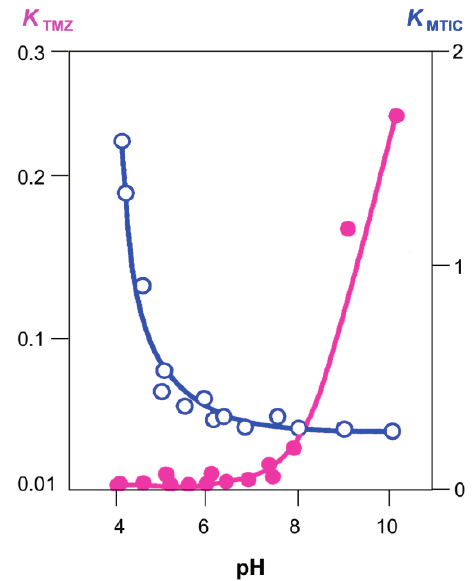
; ( B ) with full 1 H nOe in 6 and referenced to 3